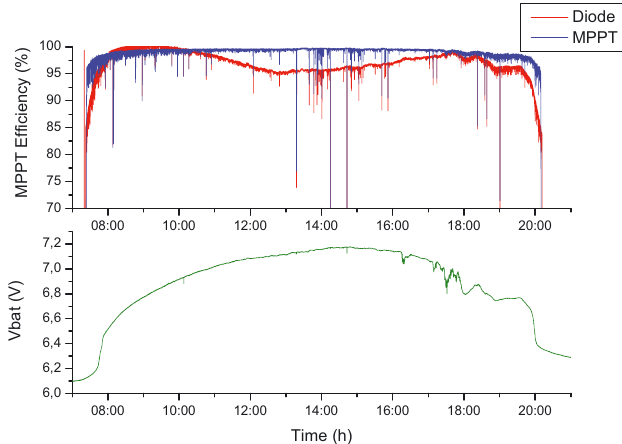
Fig. 19. Comparison of MPPT efficiencies of the two conver- sion chains on one day